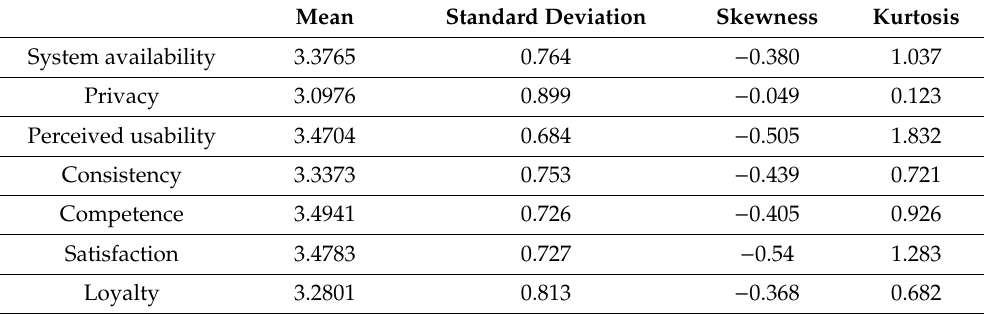
Table 3. Descriptive